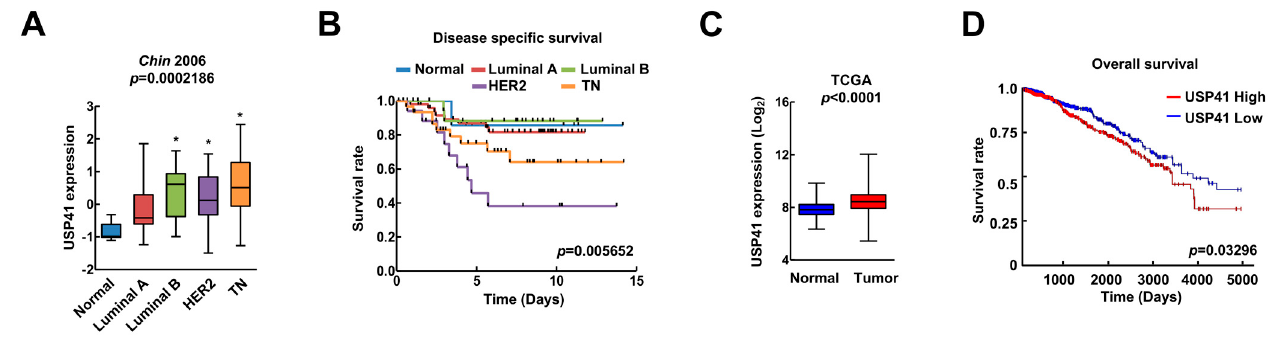
Figure 1. High expression of USP41 has poor prognosis in breast cancer patients. ( A , B ) Analysis of USP41 mRNA expression ( A ) and survival rate ( B ) according to hormonal receptor and HER2/neu status using the breast cancer dataset of Chin et al. from Xena (https://xena.ucsc.edu/). ( C , D ) Analysis of USP41 mRNA expression ( C ) and survival rate ( D ) using TCGA dataset in breast carcinoma. * P =0.0002186 compared to the Normal.